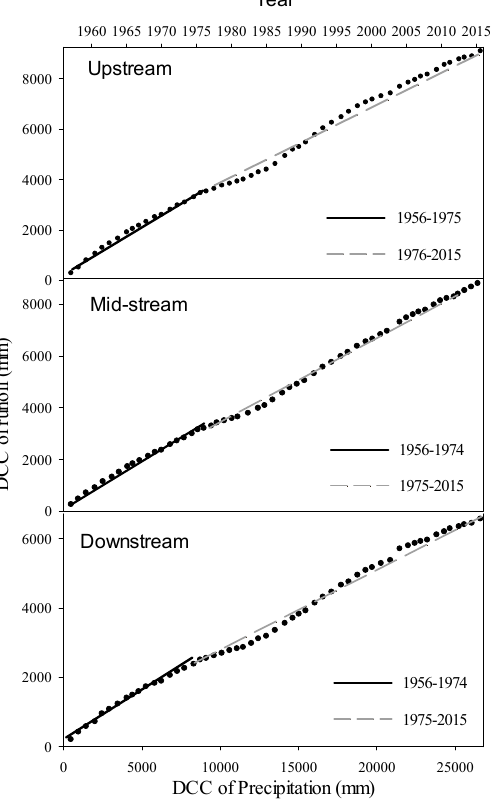
Figure 2. DCC (precipitation-runoff double cumulative curve) of rainfall-runoff in the upper, middle, and lower reaches of the Nenjiang River basin.